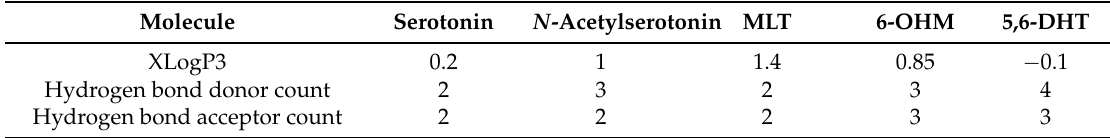
Table 1. Values of the heat of formation and the self-consistent field energy for MLT, 6-OHM and 5,6-DHT. Molecule MLT 6-OHM 5,6-DHT Heat of formation ´ 31.8208 kcal/mol ´ 77.0263 kcal/mol ´ 28.3233 kcal/mol self-consistent field energy ´ 67,768.8155 kcal/mol ´ 57,634.9772 kcal/mol Table 2. Some properties of the molecules. The data are taken from ADC/Chemsketch log P plugin (Advanced Chemistry Development, Inc., Toronto, Canada) and The PubChem Project. USA: National Center for Biotechnology Information. Molecule Serotonin N -Acetylserotonin MLT 6-OHM 5,6-DHT XLogP3 0.2 1 1.4 0.85 ´ 0.1 Hydrogen bond donor